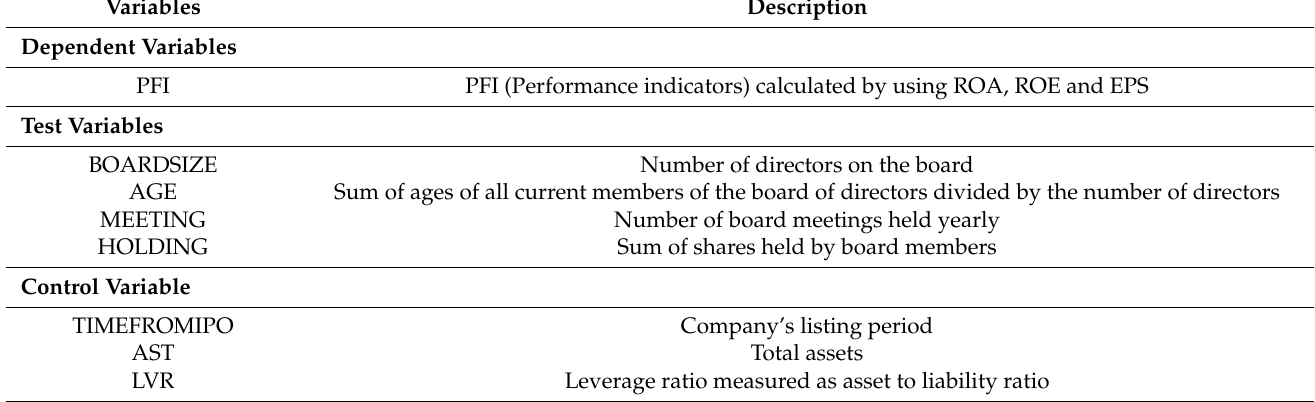
Table 1. Variables